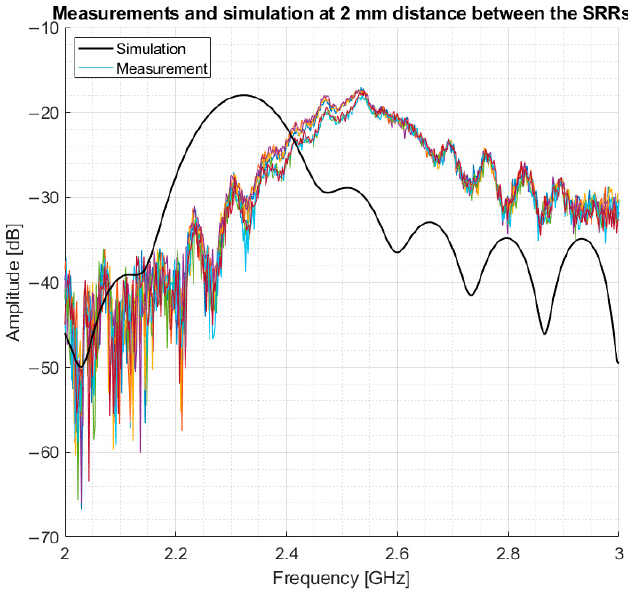
Figure 12. Comparison between volunteer measurements and simulation.